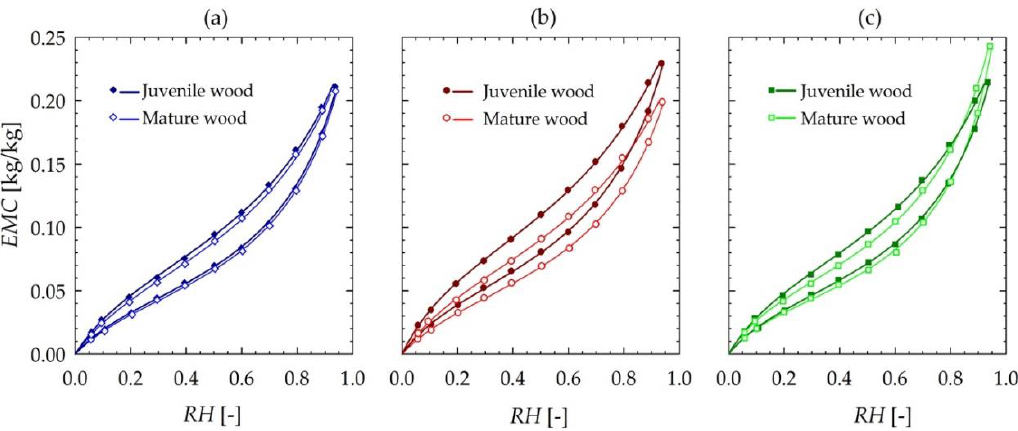
Figure 5. Experimental sorption data (dots) and results of modelling (lines) with Guggenheim, Anderson, and de Boer (GAB) model of the juvenile and mature lime ( Tilia cordata Mill.) wood at 20 °C take into account growth conditions ( a )—forest (A), ( b )—roadside (B), ( c )—urban agglomeration (C).